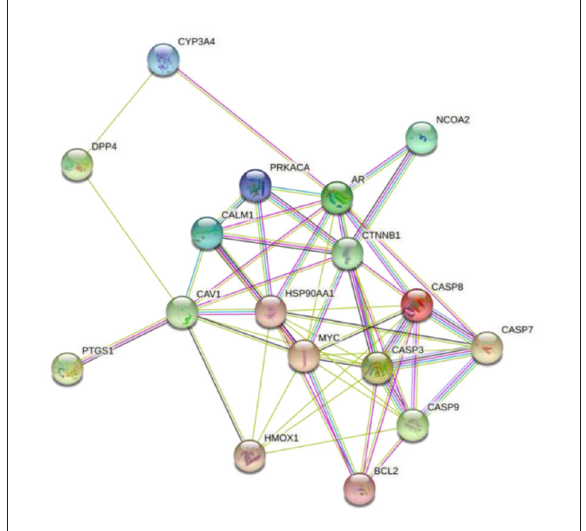
FIGURE3 The protein–protein interaction (PPI) network of mung bean putative and oxidative and free radical damage-related target genes.